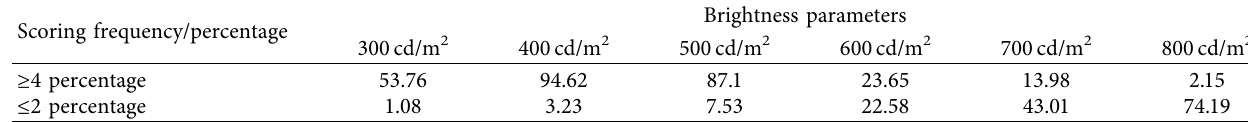
Table 5: Calculation table of threshold limit value of visual comfort brightness change